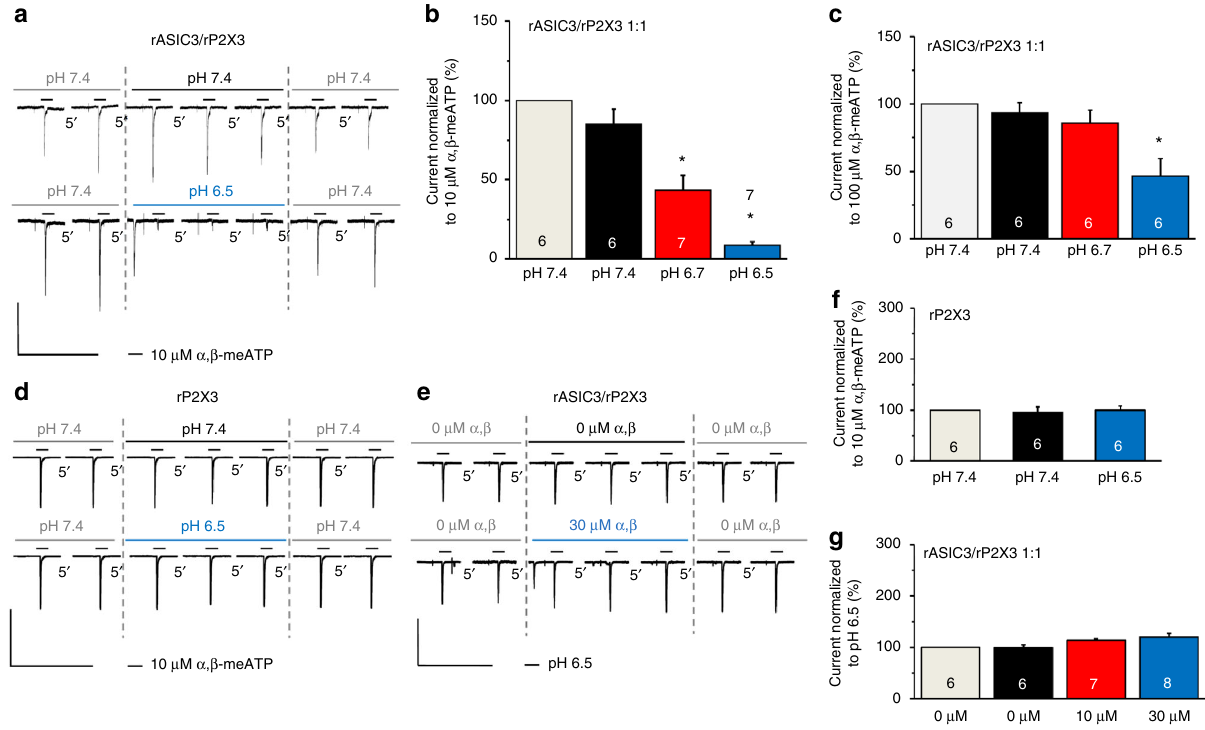
Fig. 2 Interaction between rASIC3 and rP2X3Rs after their transfection into CHO cells. CHO cells were transfected with rASIC3 and rP2X3Rs in a 1:1 ratio or transfected only with rP2X3R as indicated. Whole-cell patch-clamp recordings at a holding potential of − 65 mV. a – c Interaction between rASIC3 and rP2X3Rs on their sequential activation by agonists. Current responses were elicited by α , β -meATP (10 or 100 µ M) for 2 s with 5 min intervals before, during and after a shift in pH from 7.4 to 6.7 or 6.5. The reproducibility of the responses to α , β -meATP after changing to a solution with the same pH of 7.4 is also shown. d , f No effect of protons on rP2X3Rs. Current responses were elicited by α , β -meATP (10 µ M) for 2 s with 5 min intervals before, during and after a shift in pH from 7.4 to 6.5. e , g No effect of α , β -meATP (10 and 30 µ M) on the proton-induced inward current on the sequential activation of rP2X3 and rASIC3Rs. Stable responses to pH 6.5 in the absence of α , β -meATP is also shown. Percentage changes of α , β -meATP (10 and 100 µ M)-induced current responses were calculated with respect to the second current before the pH shift to 6.7 or 6.5 ( b , c , f ). Percentage changes of proton (pH 6.5)-induced current responses were calculated with respect to the second current amplitude before the application of α , β -meATP (0, 10 and 30 µ M) ( g ). Means ± S.E. M. of the indicated number of experiments. * P < 0.05; statistically signi fi cant difference between the current amplitudes before and after the long-lasting shift in pH or the long-lasting presence of α , β -meATP (one-way ANOVA followed by the Bonferroni test). The scale labels for the vertical bars were 500 pA ( a ) and 2 nA ( d , e ). The scale labels for the horizontal bars were 50 s ( a , d , e )